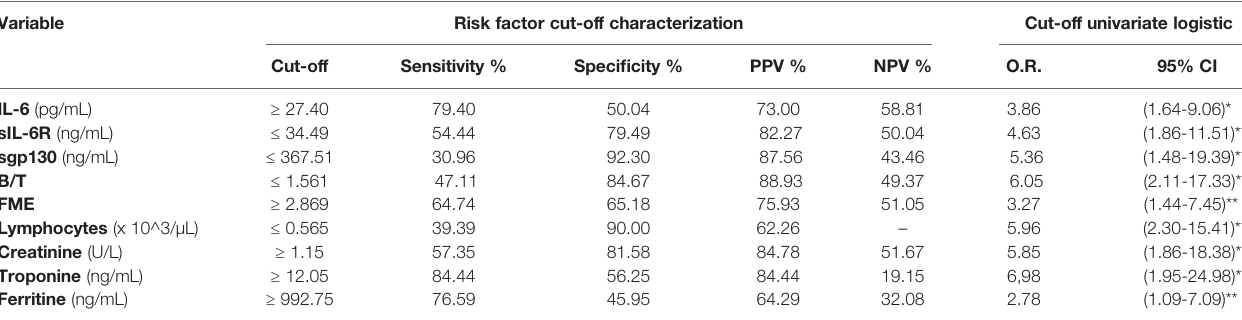
TABLE 3A | Univariate logistic regression analyses of IL-6 signalling biomarkers as predictors of COVID-19 mortality. Variable